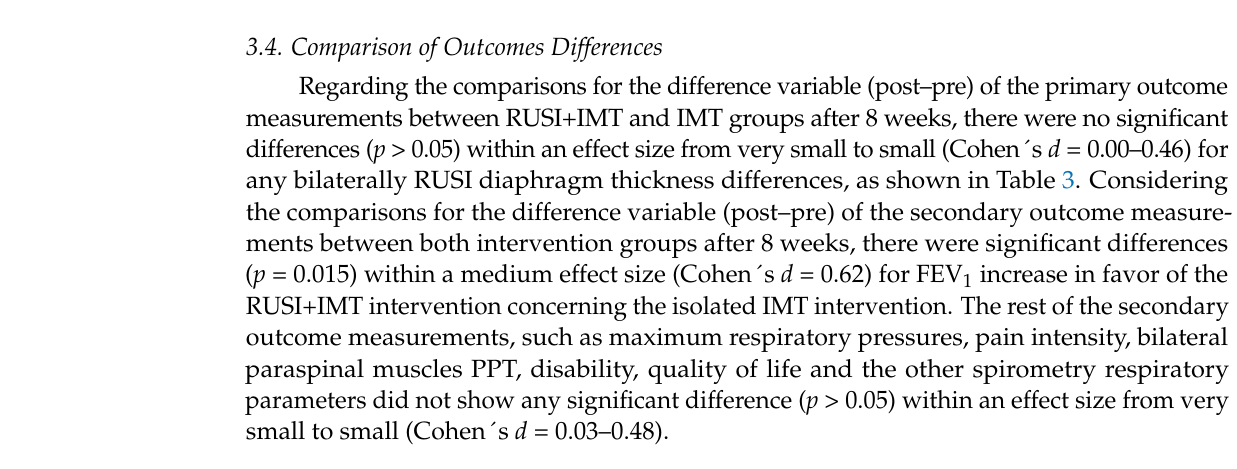
Table 3. Comparisons for outcome measurements differences after 8 weeks between RUSI+IMT and IMT